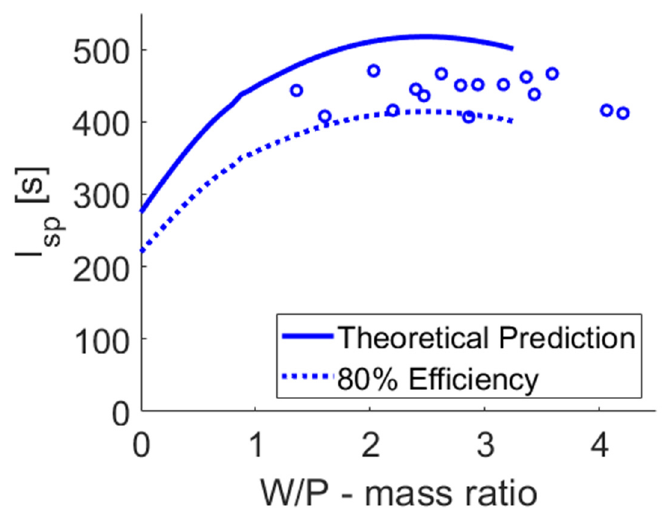
Figure 6. Theoretical and static firing test results of the standard specific impulse vs. the water– propellant mass ratio for a hybrid-propellant, water-breathing ramjet fueled with 80% polyester and 20% aluminum.